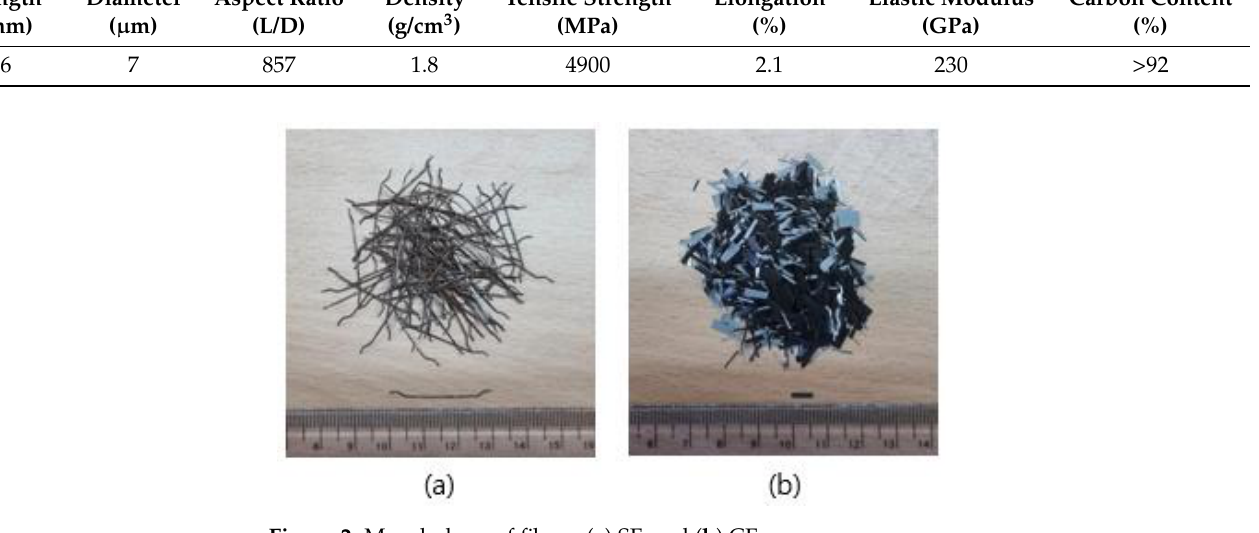
Figure 2. Morphology of fibers; ( a ) SF, and ( b ) CF.